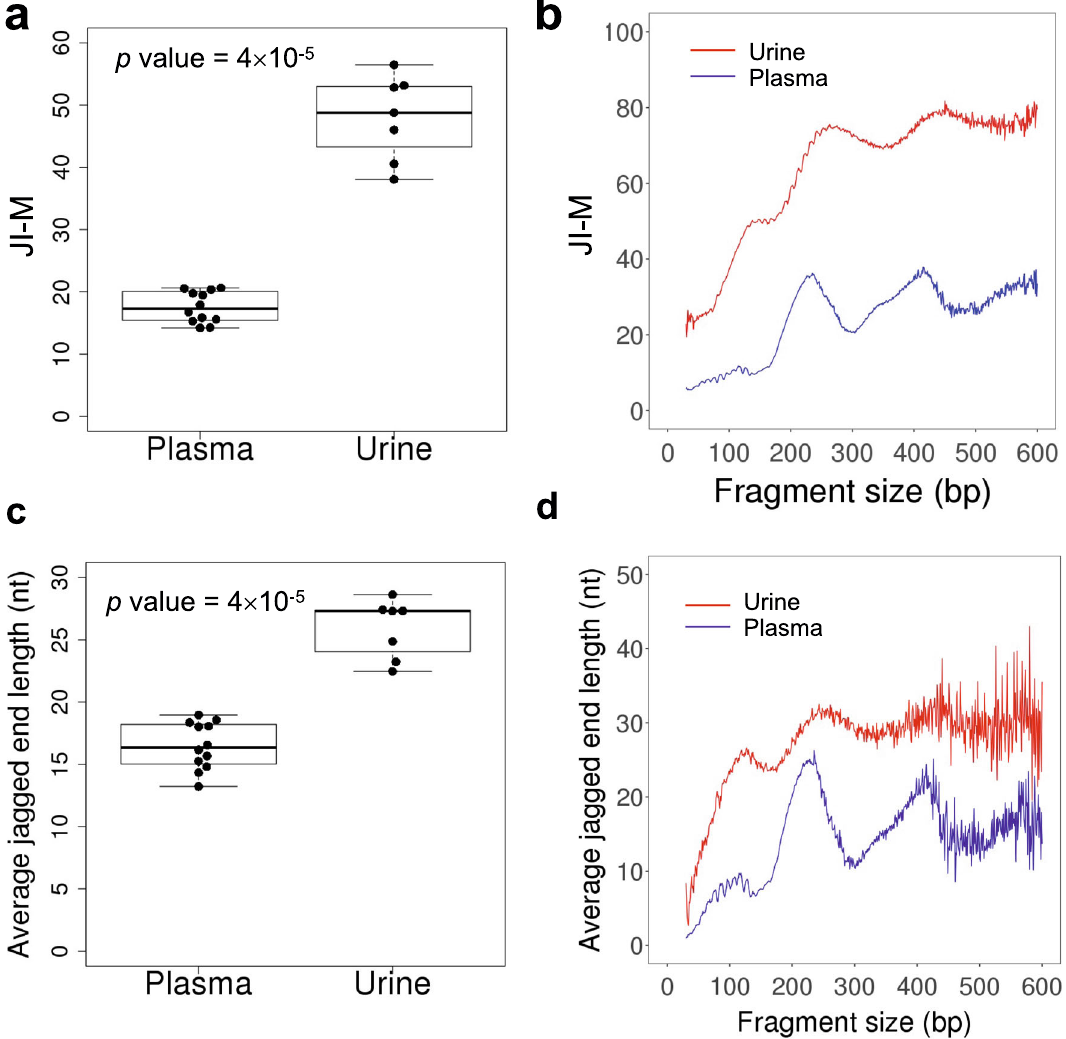
Fig. 3 Comparison of jagged ends between plasma and urinary DNA. a , b CH methylation level in read2 (JI-M) across the different fragment sizes. c , d Average jagged end length across the different fragment sizes. The central line indicates the median value. The bottom and top of the boxes are the 25th and 75th percentiles (interquartile range). The whiskers encompass 1.5 times the interquartile